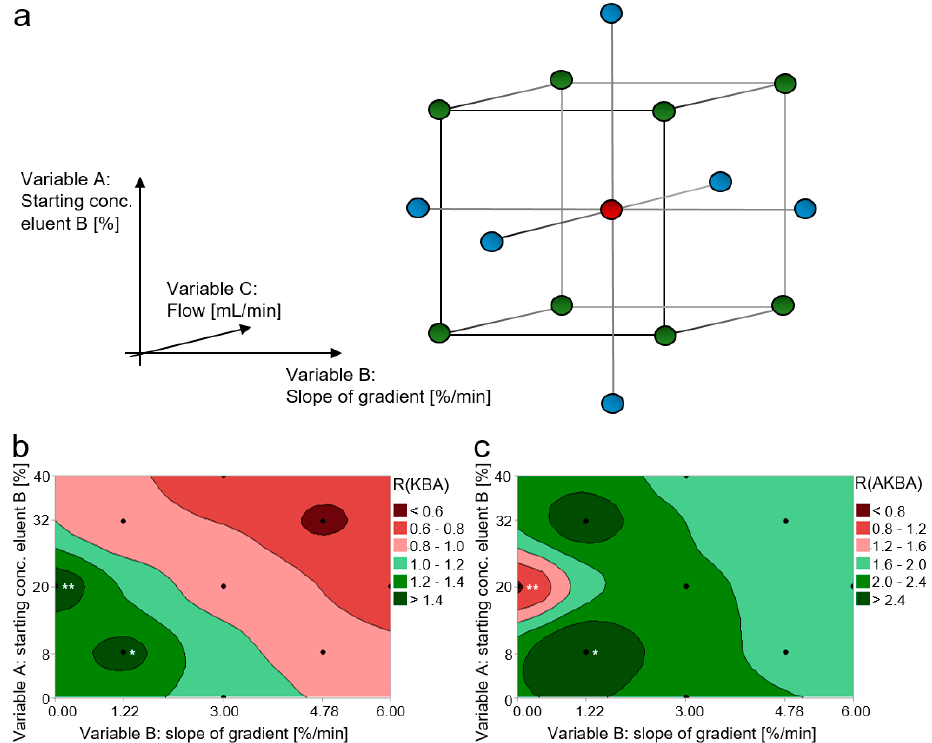
Figure 4. Design of Experiments (DoE) for the development of a chromatographic method to separate the constitutional isomers of keto-boswellic acids (KBAs) and acetyl-keto-boswellic acids (AKBAs). ( a ) Three-factorial central composite design (CCD) with the starting concentration of eluent B as variable A, the slope of the gradient as variable B, and the eluent´s flow as variable C. Whereby, the central composite design is composed of a full two-level factorial (green dots), axial points (blue dots), and a center point (red dot). ( b ) Effect of variables A and B on the chromatographic resolution R(KBA) between 11-keto- α -boswellic acid ( α -KBA) and 11-keto- β -boswellic acid ( β -KBA). ( c ) Effect of variables A and B on the chromatographic resolution R(AKBA) between acetyl-11-keto- α -boswellic acid ( α -AKBA) and acety-11-keto- β -boswellic acid ( β -AKBA). Black dots represent the level configurations of the individual experiments. Only the level configurations of experiment 5 (*) enabled a separation of all four isomers. The level configurations of experiment 11 (**) allowed the separation of KBA ´ s isomers, but the isomers of AKBA could not be eluted under these